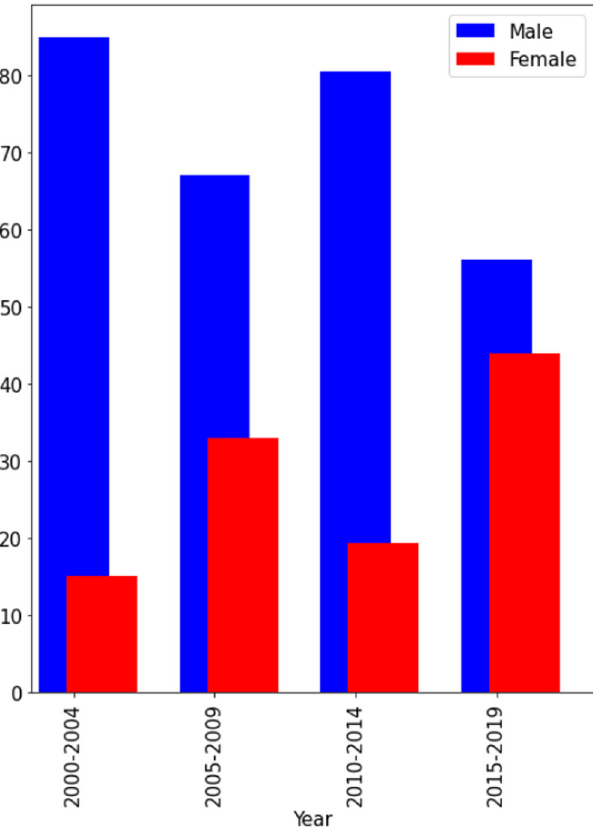
Fig. 6 Distribution of gender based on their presence in movies. Gender distribution over the years based on the number of dialogues and the number of their presence in movies.